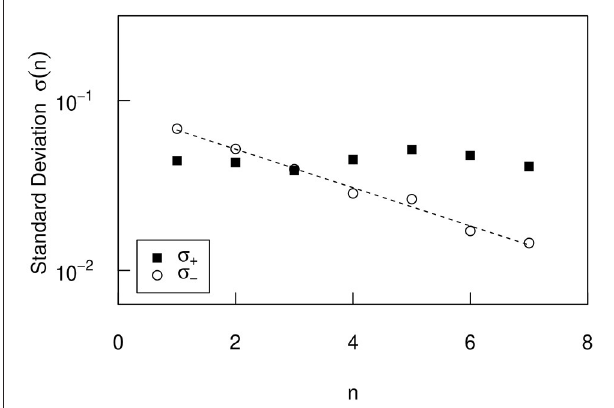
FIGURE 7 | The n dependence of the positive and negative standard deviations σ ± of the conditional PDFs in Italy.